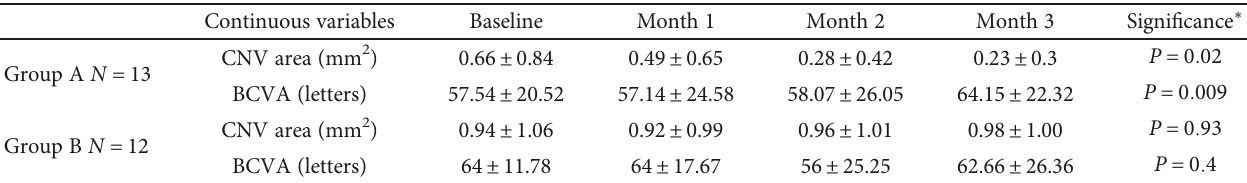
Table 2: Comparison of continuous variables between baseline and month 3 in groups A and B. Note that the CNV area decreased signi fi cantly in group A ( P = 0 02 ) from baseline to month 3 and that BCVA improved in a statistically signi fi cant manner in group A from baseline to month 3 ( P = 0 009 ).